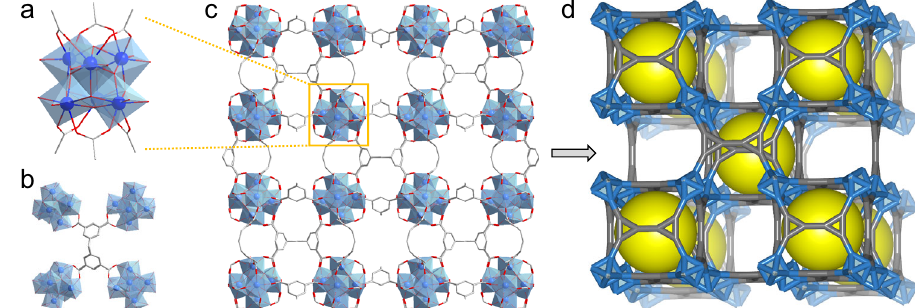
Fig. 1 Crystal structure of MIP-201. a The 6-connected Zr 6 -oxo-cluster building unit with the trigonal prismatic con fi guration. b One tetracarboxylate linker molecule connects the adjacent four Zr 6 -oxo clusters. c The overall structure viewed along the c axis. d The square – octahedron (soc) topological net of MIP-201 structure (Zr in blue, C in gray, O in red, and the yellow ball stands for